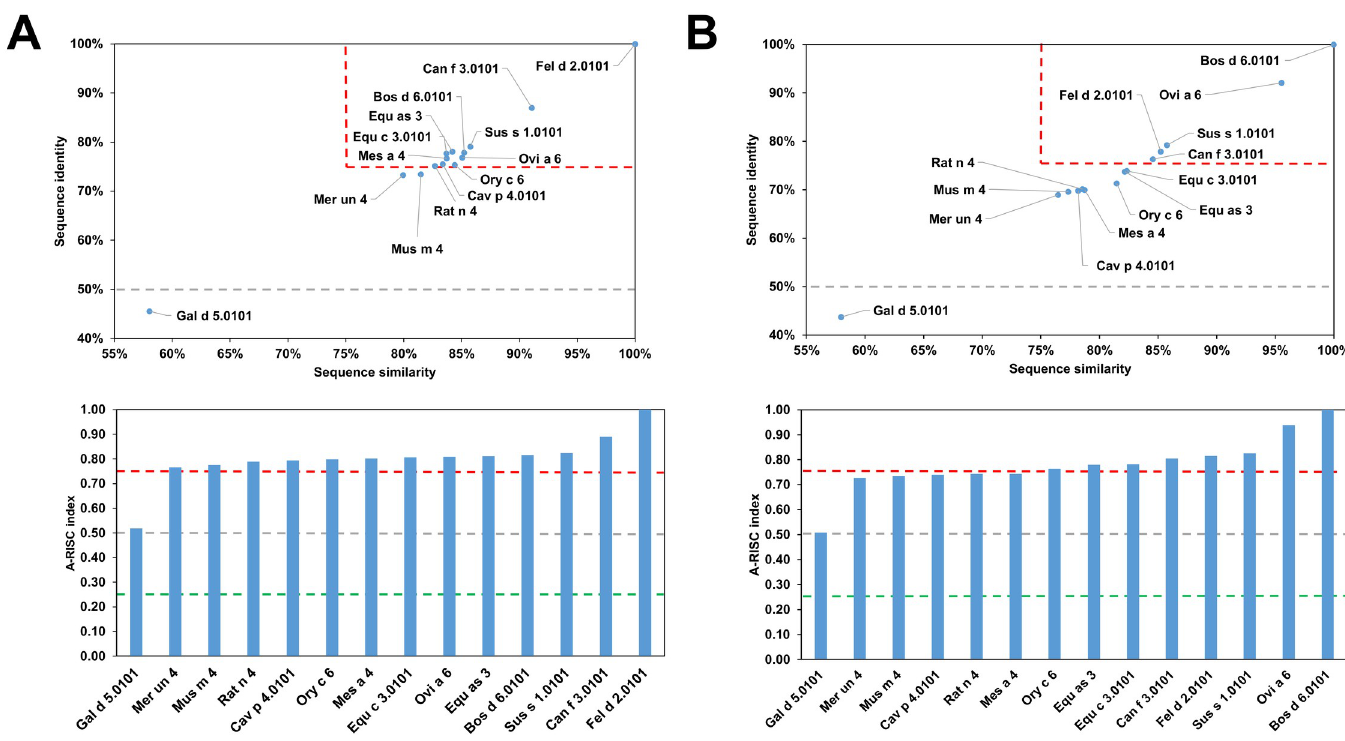
Fig 7. Plots showing relative homology and A-RISC indexes of allergens from serum albumin family. Comparison of family members to Fel d 2.0101 (A) and Bos d 6.0101 (B). Red, gray, and dark green dashed lines indicate respectively 75%, 50% and 25% sequence identity and similarity, or 0.75, 0.50 and 0.25 A-RISC values.